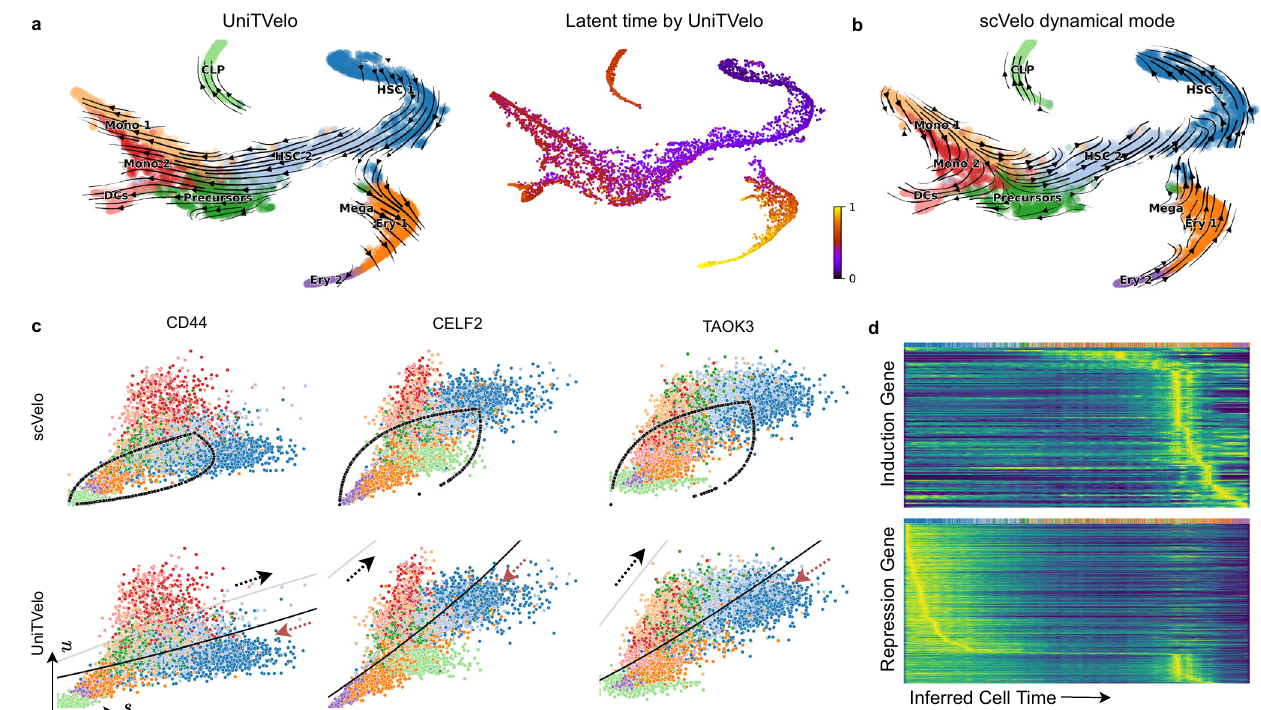
Fig. 3 | UniTVelo correctly identi fi es differentiation trajectory of human bone marrow development. a UMAP coordinates of the velocity fi eld shown in streamlines(left)andpredictedlatenttime(right)fromUniTVelo. b EstimatedRNA velocity fi eld in streamlines by scVelo. c Cd44 , Celf2, and Taok3 are selected as examples, illustrating UniTVelo could accurately capture cell states and direc- tionality whilst scVelo failed to capture the relative cell states using almond shape phaseportraits.Upperpanel:RegressionresultbyscVelo.Lowerpanel:Inferredcell